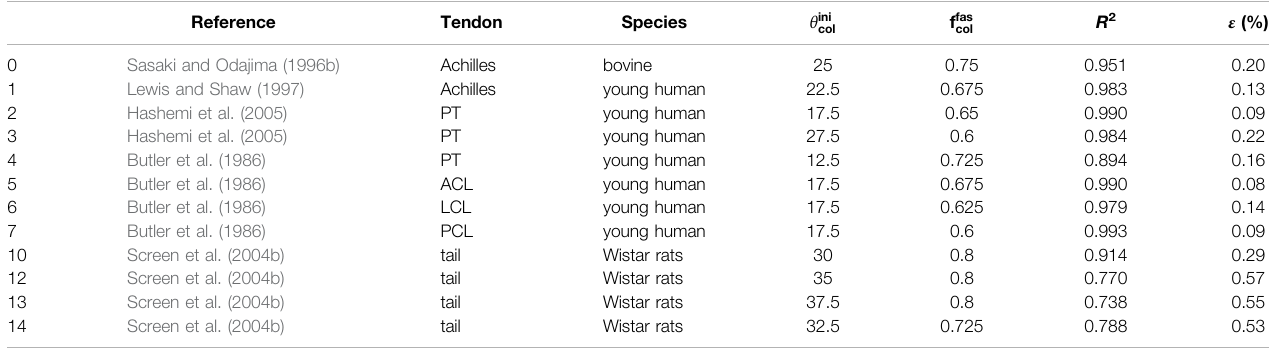
TABLE 3 | Collection of experimental references for stretch-stress data given in Figures 7 , 8 , together with optimized values for initial fi ber orientation and collagen volume fraction, in order to reach the coef fi cients of determination and the residual errors in the last two columns; all other model input data are found in Table 4 .